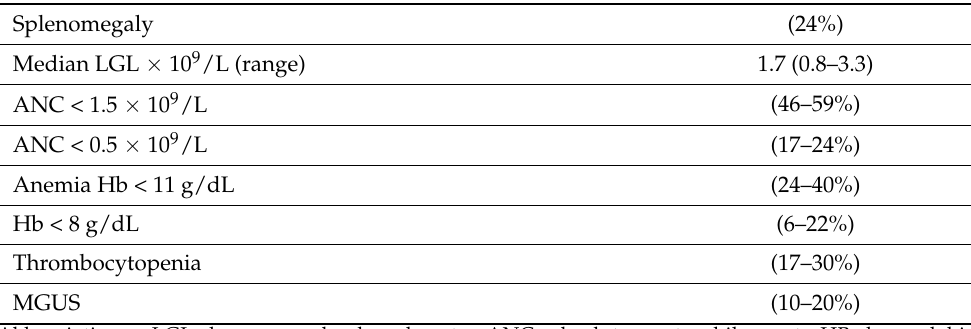
Table 1. Hematological disorders in LGL leukemia. Data from the two largest retrospective series [35,36].